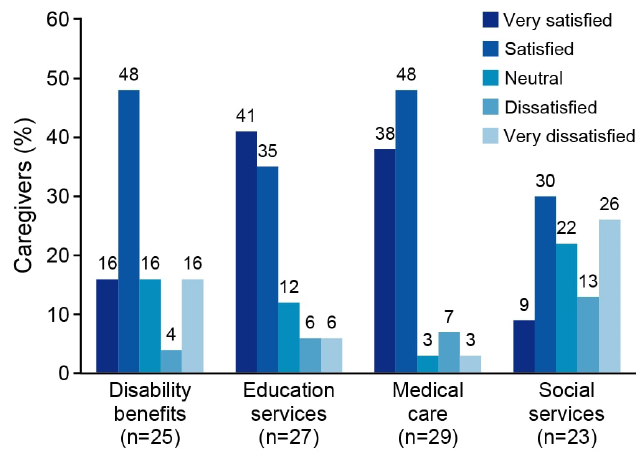
Figure 4. Caregiver satisfaction with support received by child (excludes adult